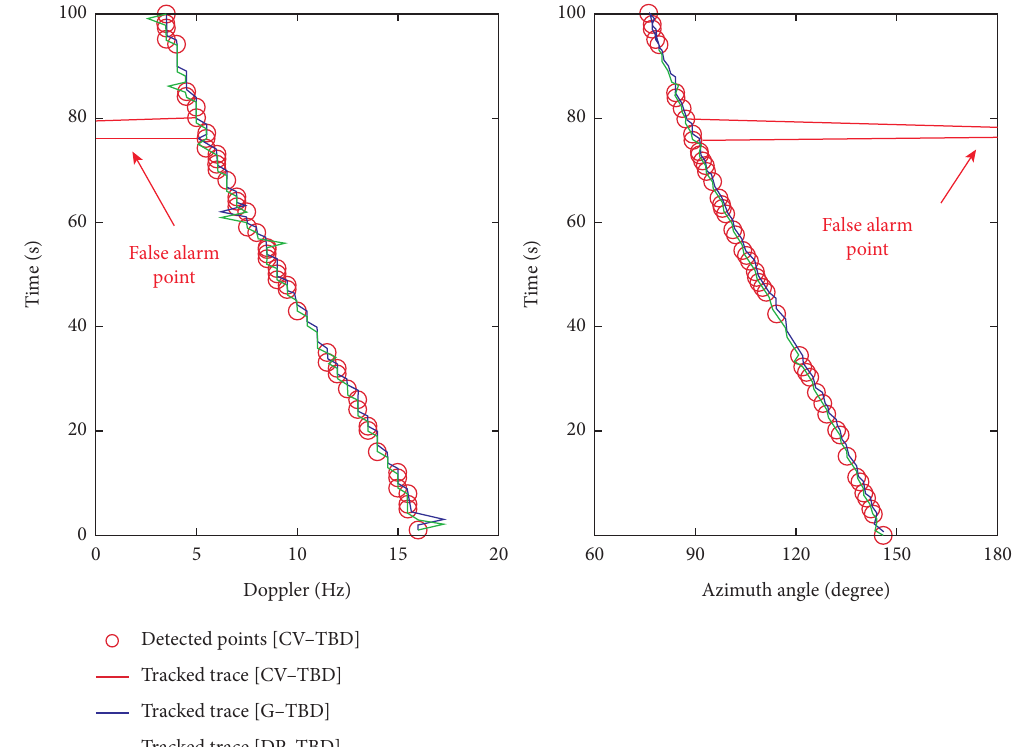
Figure 11: Tracked time-doppler trace and time-azimuth trace.